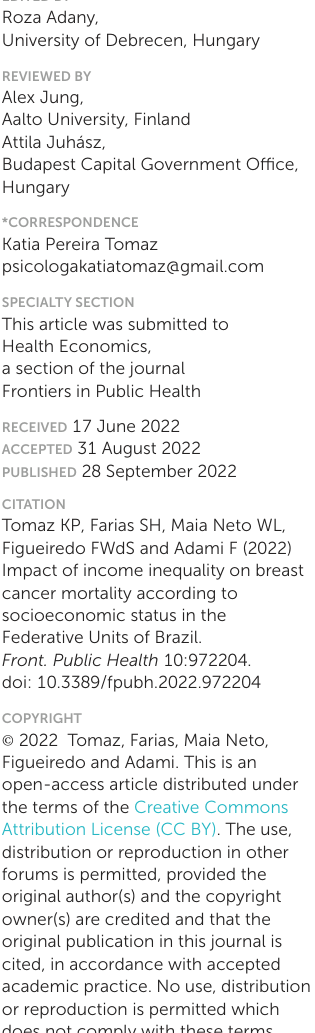
Figueiredo FWdS and Adami F (2022) Impact of income inequality on breast cancer mortality according to socioeconomic status in the Federative Units of Brazil. Front. Public Health